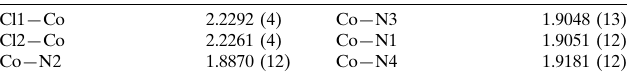
Selected bond lengths (A˚ ).